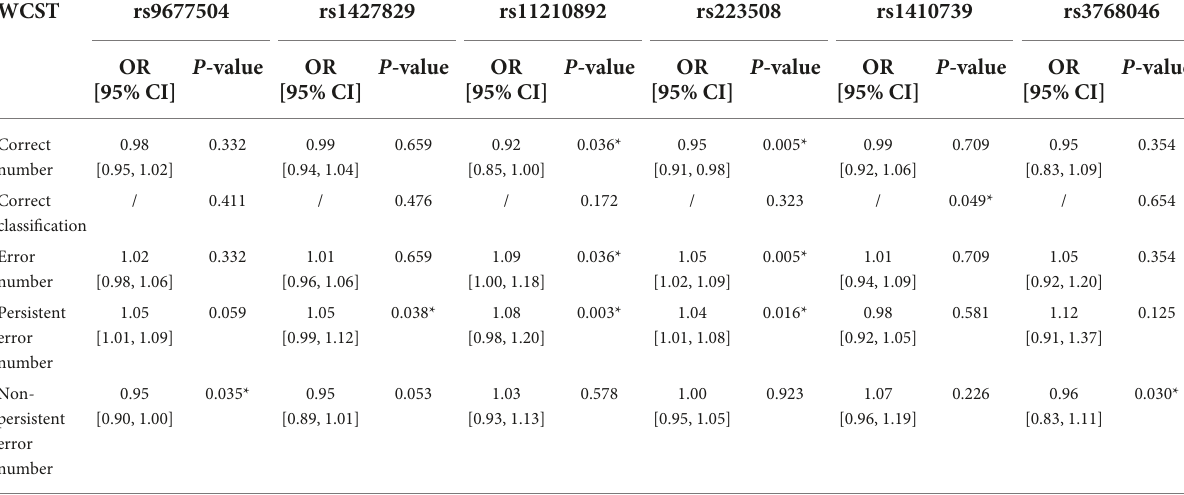
TABLE 3 Multivariate analysis results of the influence of SNPs on the ability for abstract thinking of children with ADHD.